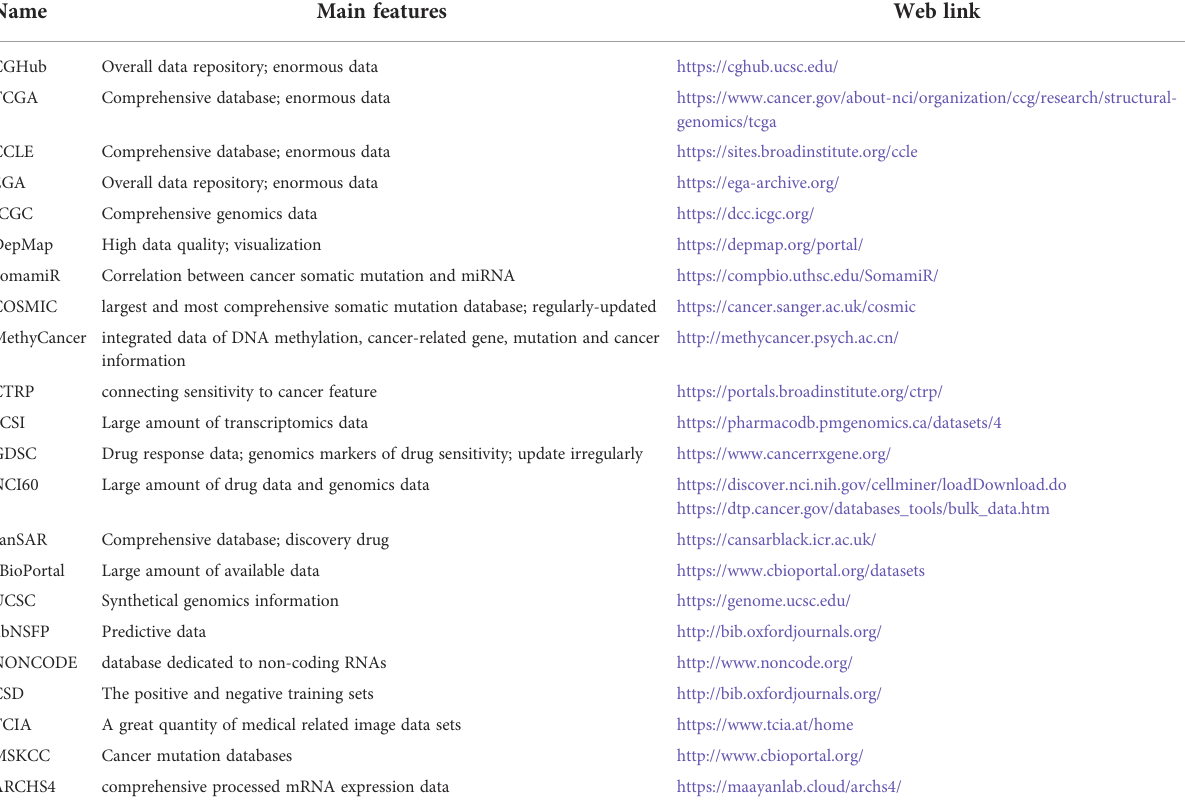
TABLE 1 Comprehensive omics database resources for building AI